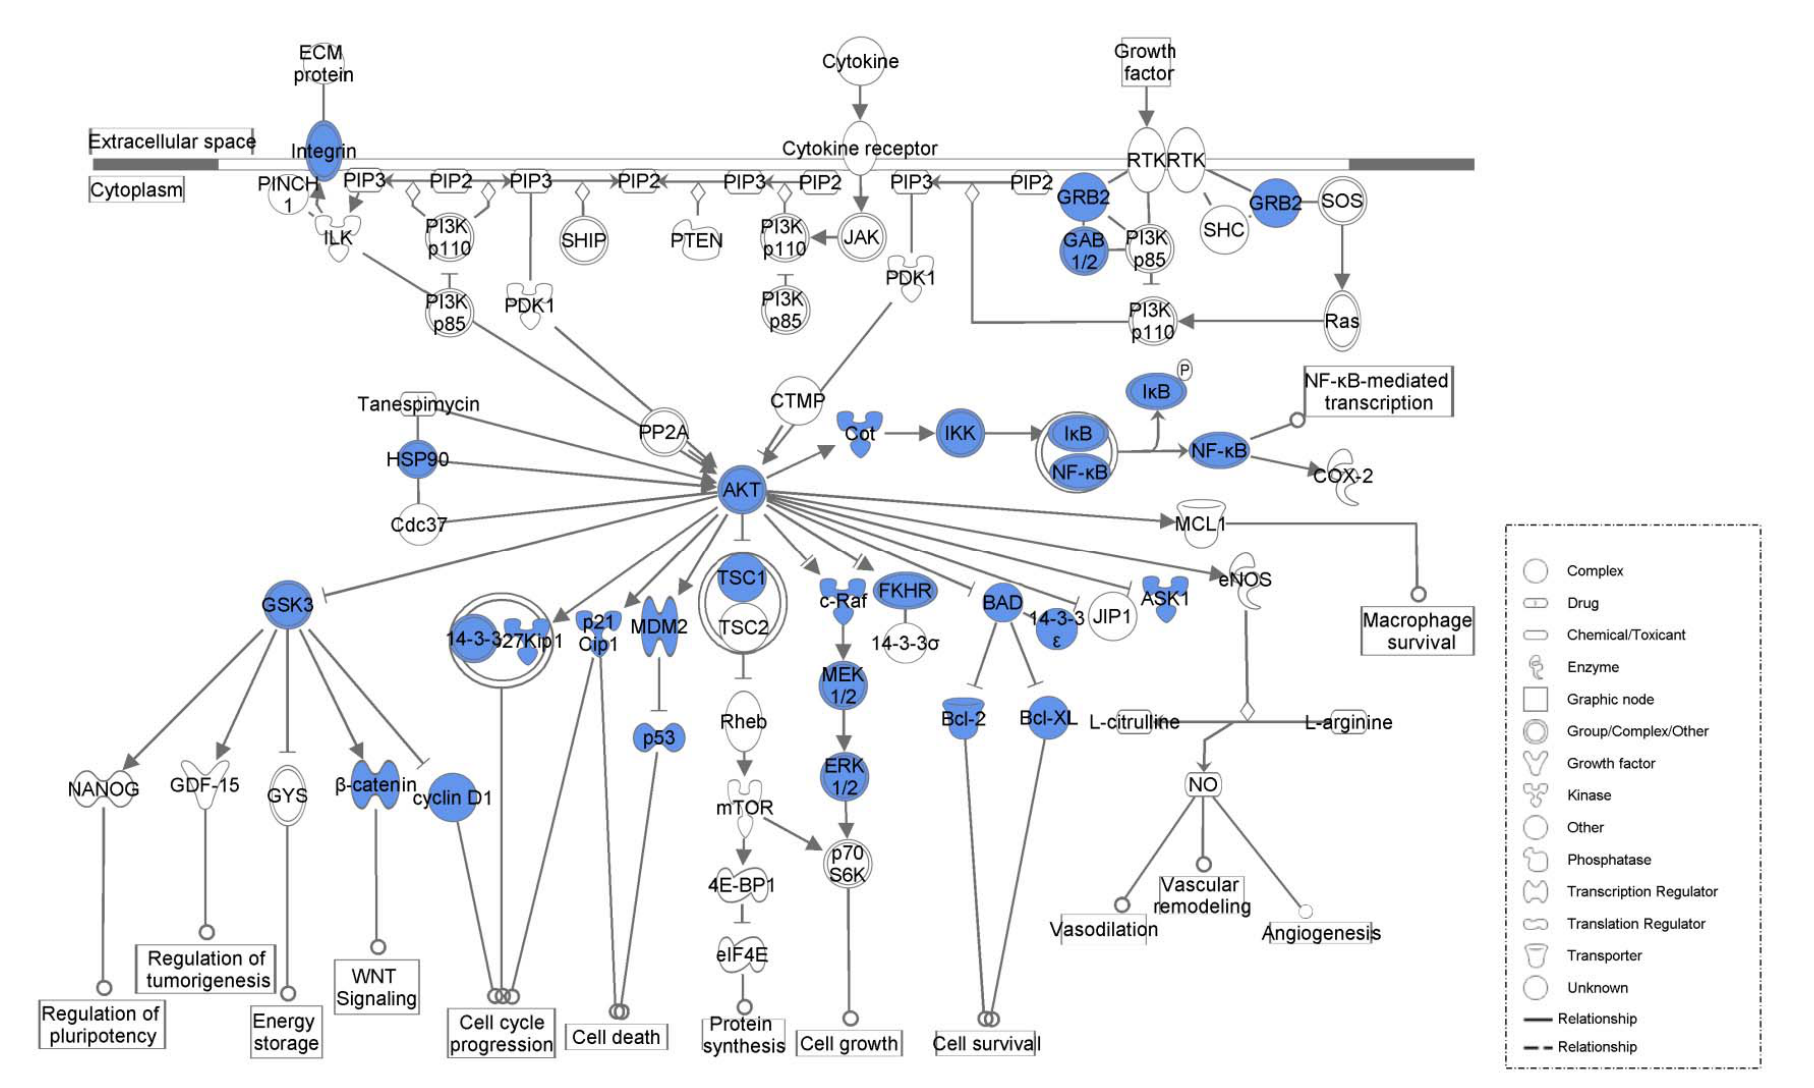
Figure 3. PI3K/AKT signaling associated with the common network. Blue legends represent proteins contained in the common